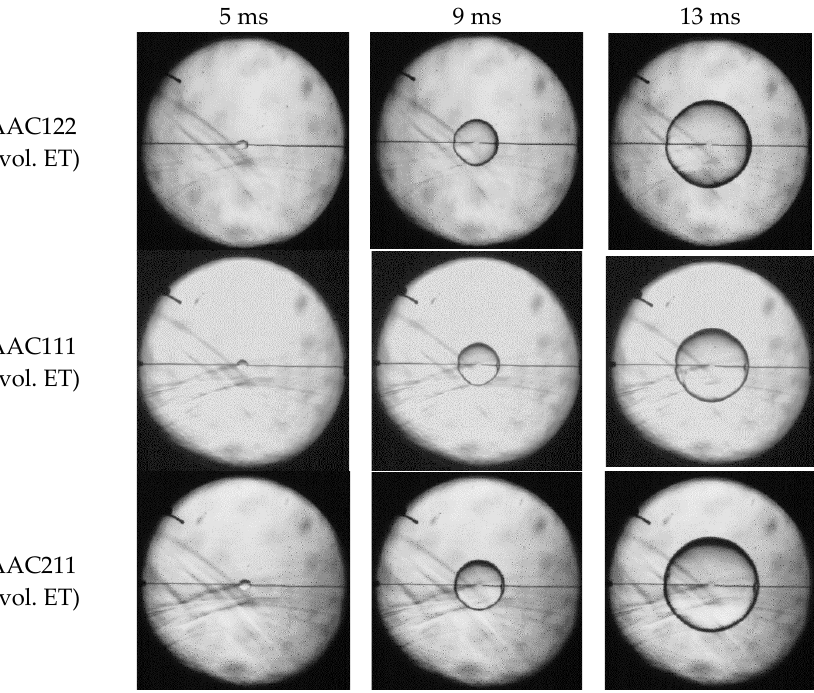
Figure 2. Flame propagation images of ETEAAC122, ETEAAC111, and ETEAAC211 at T 0 = 358 K, P 0 = 1 bar, and ϕ = 1.1.